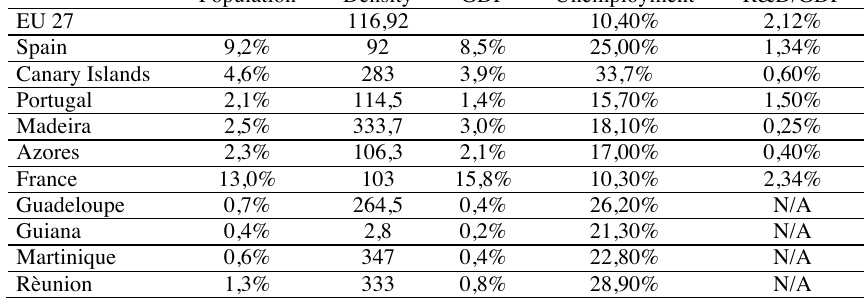
Table 1. Socio-economic situation currently faced by ORs